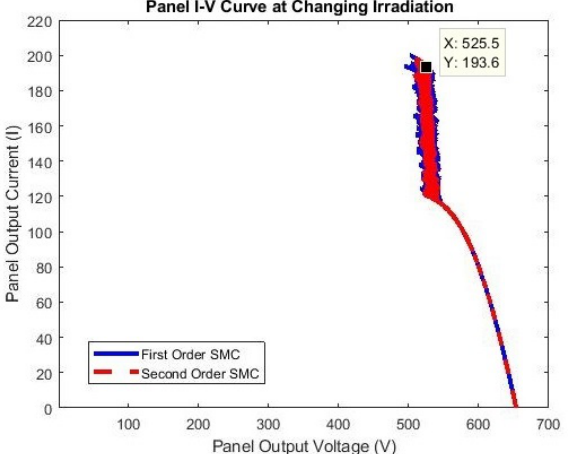
Figure 18. PV array I-V characteristic under changing